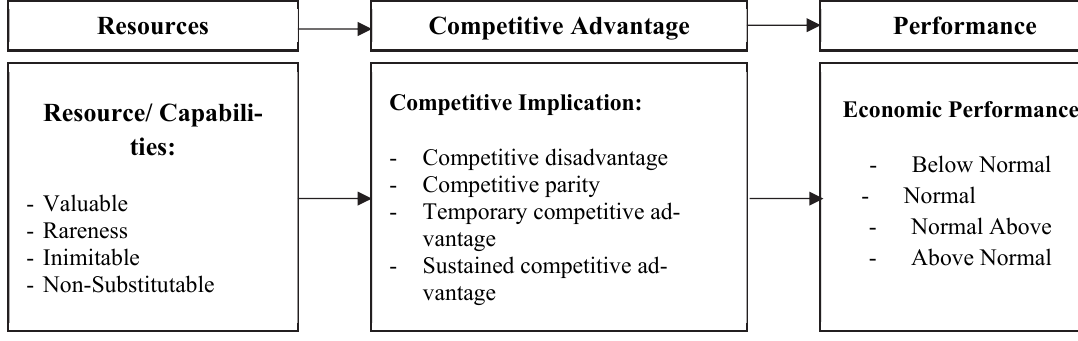
Fig. 2. Linkage Resource with Competitive Advantage Source: Barney,